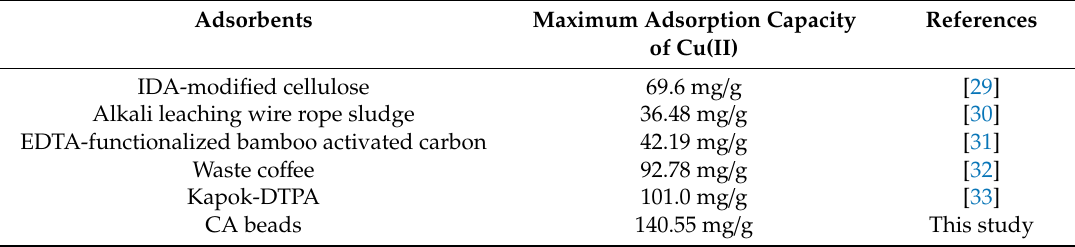
Table 3. Comparison of adsorption capacity of low-cost adsorbents for Cu(II).